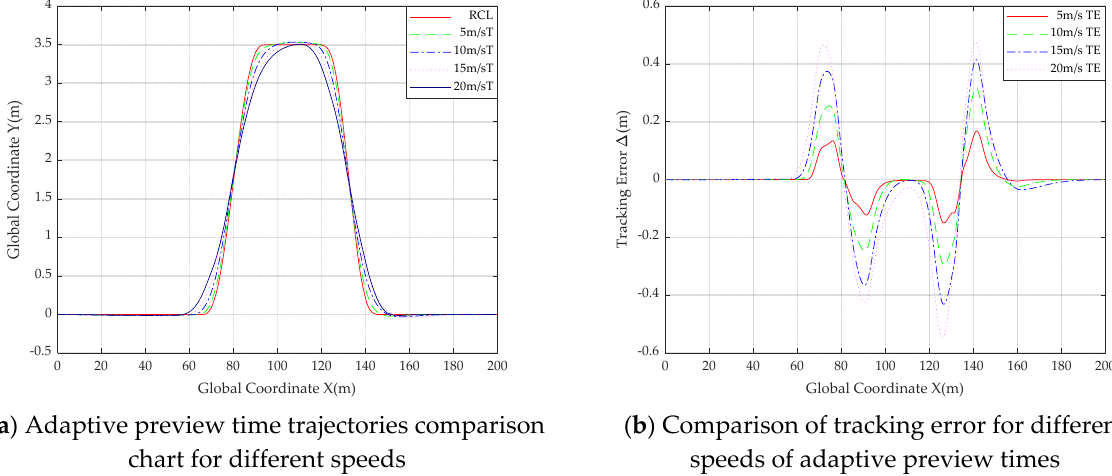
( b ) Comparison of tracking error for different speeds of adaptive preview times Figure 18. Comparison of trajectories and tracking error for different speeds of adaptive preview time.